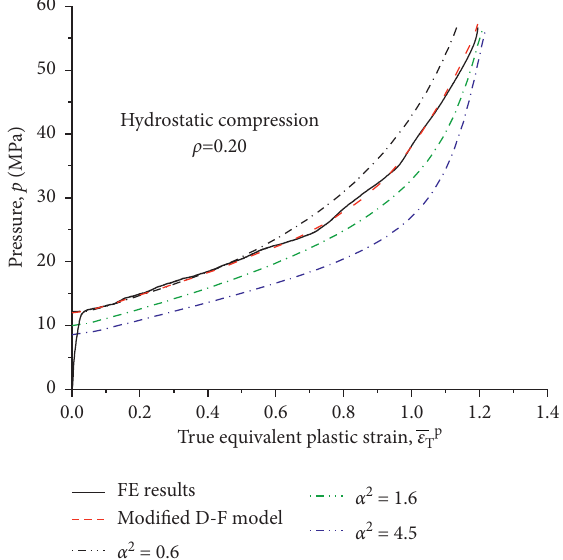
Figure 21: Predictions of the pressure under hydrostatic com- pression according to the second-type D-F model and the modified D-F